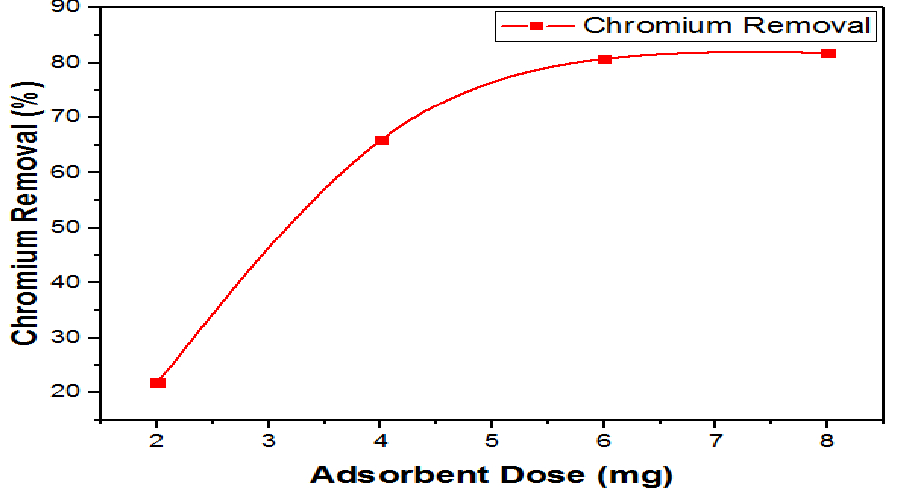
Figure 15. Effects of adsorbent dosage on removal of Cr (VI).